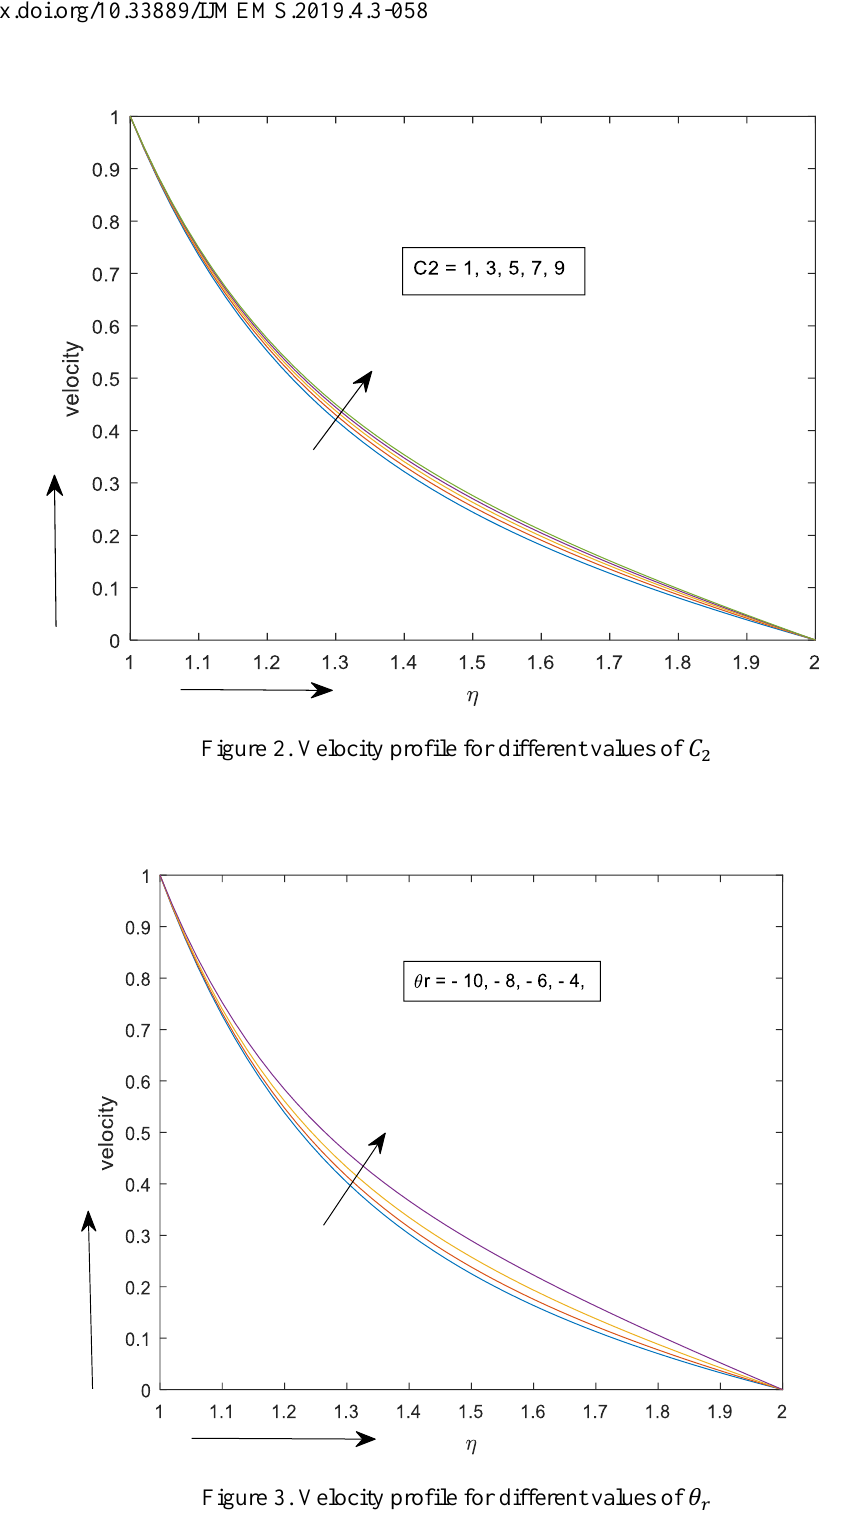
Figure 3. Velocity profile for different values of 𝜃